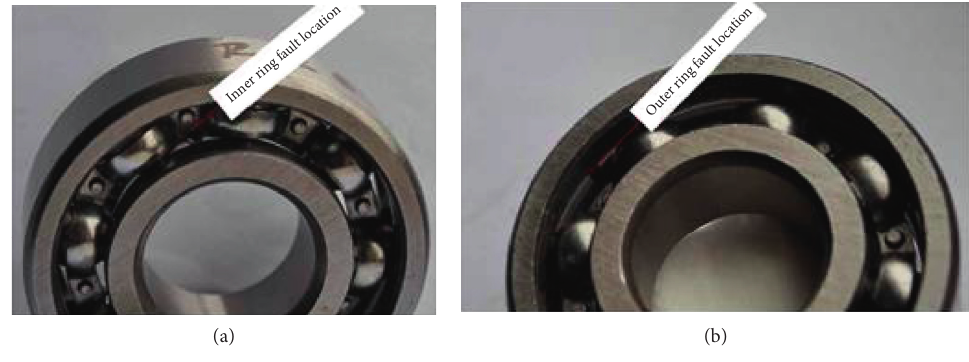
Figure 15: Photos of faulty bearings. Table 4: Characteristic frequencies of bearings and gear mesh frequency.